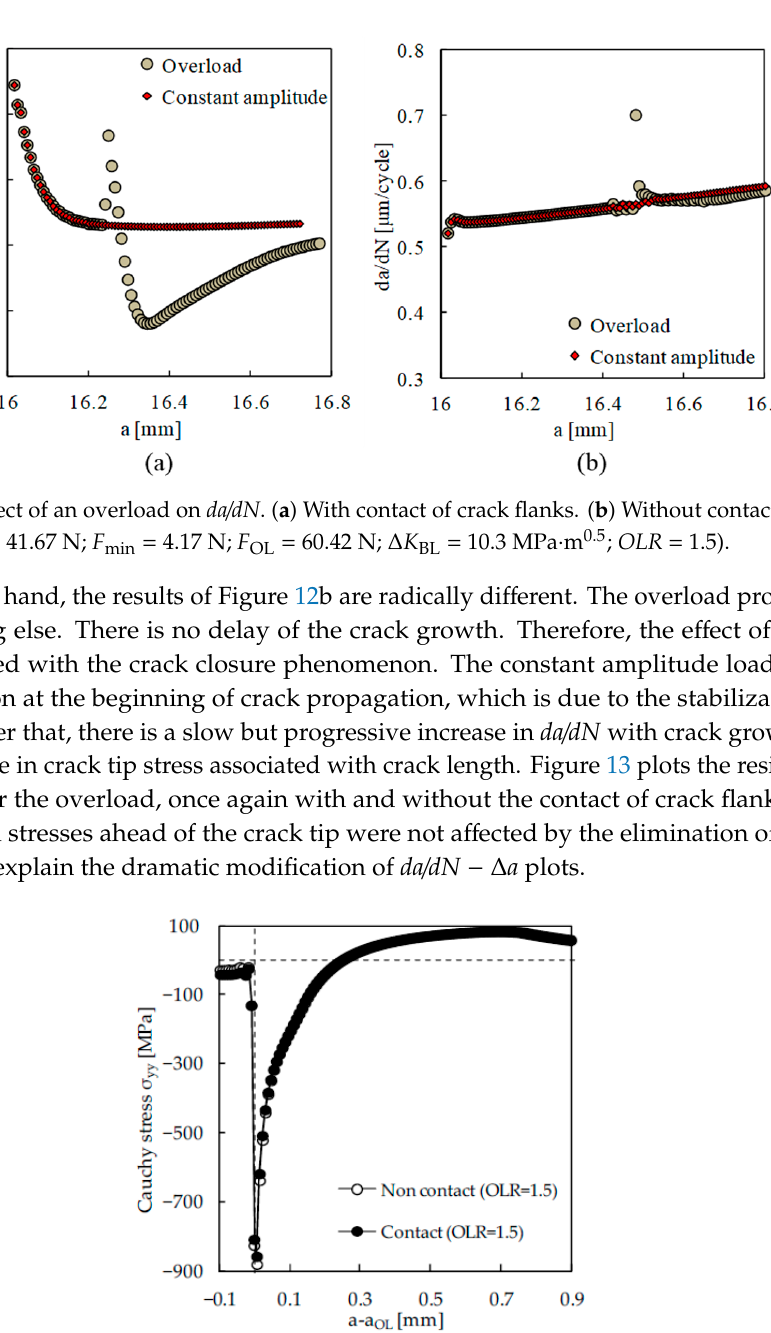
Figure 13. Contact stresses at minimum load immediately after the application of an overload ( F max = 41.67 N; F min = 4.17 N; F OL = 60.42 N; Δ K BL = 10.3 MPa·m 0.5 ; OLR = 1.5).